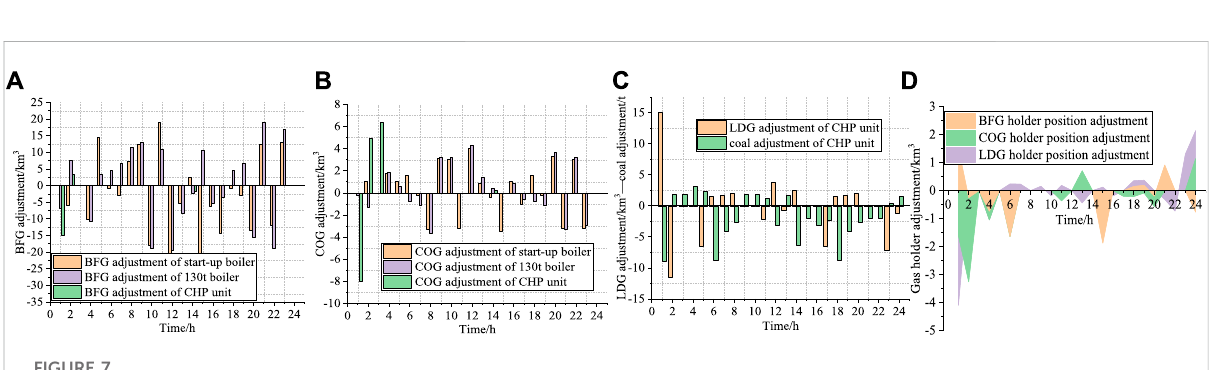
FIGURE 7 Theoperationstatusofeachpieceofequipmentunderreal-timerescheduling. (A) :AdjustmentofBFG (B) :Adjustment ofCOG (C) :Adjustment of LDG and coal (D) : Adjustment of the gas holder position.